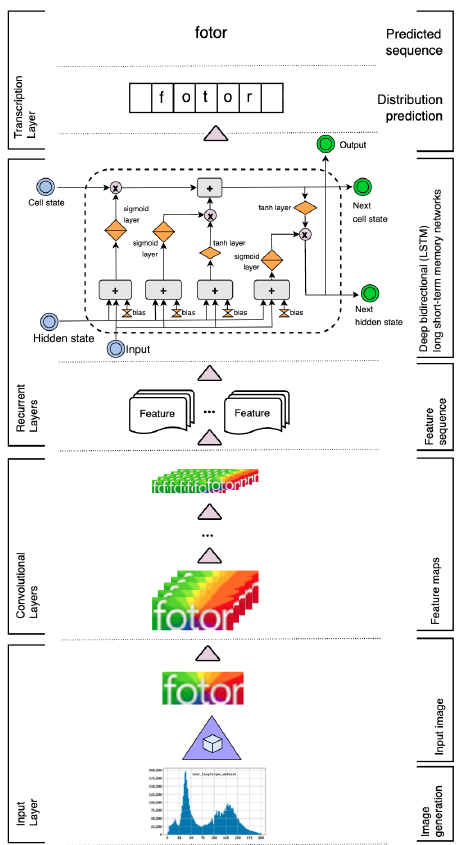
Figure 3. CRNN architecture [33] with CRNN feature extraction, adapted from